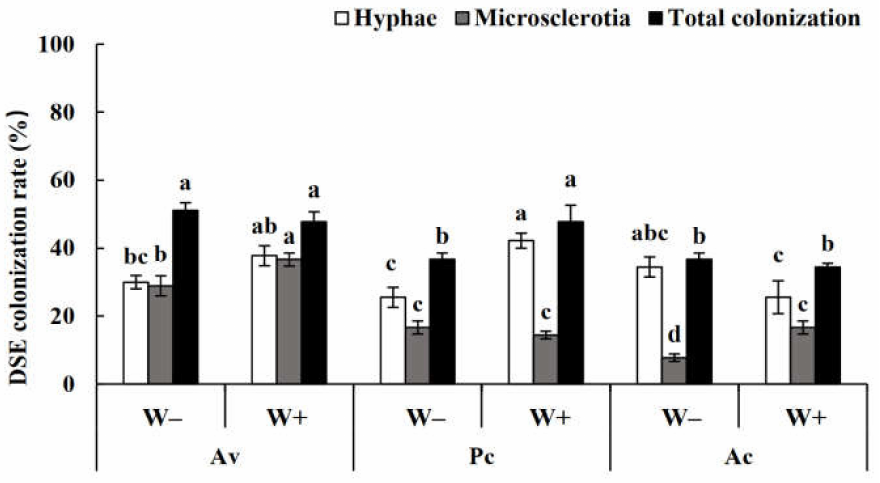
Figure 9. Dark septate endophyte (DSE) colonization rate in the roots of Artemisia ordosica inoculated with DSEs under drought stress. Note: W − , drought treatment. W+, well-watered treatment. Ac, Alternaria chartarum . Pc, Paraphoma chrysanthemicola . Av, Acrocalymma vagum . Different letters above the error bars indicate a significant difference at p <